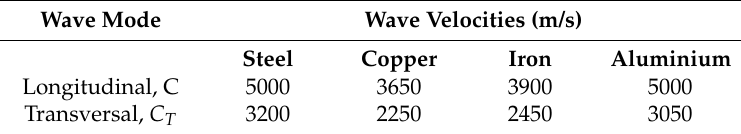
Table 1. Velocities of stress wave in different metal